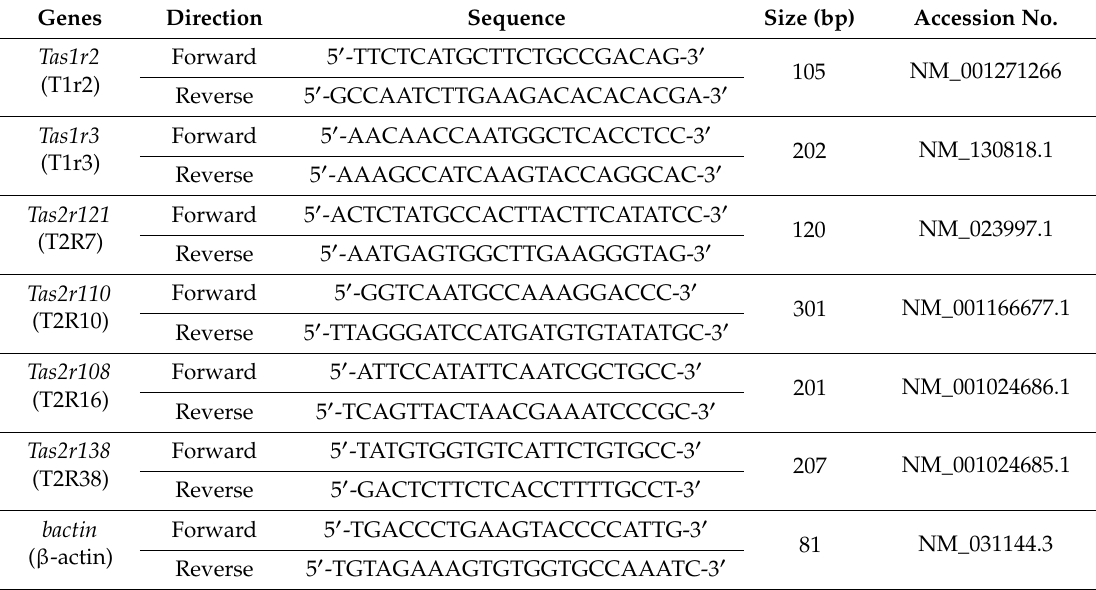
Table 1. Primer sets used for quantitative real-time